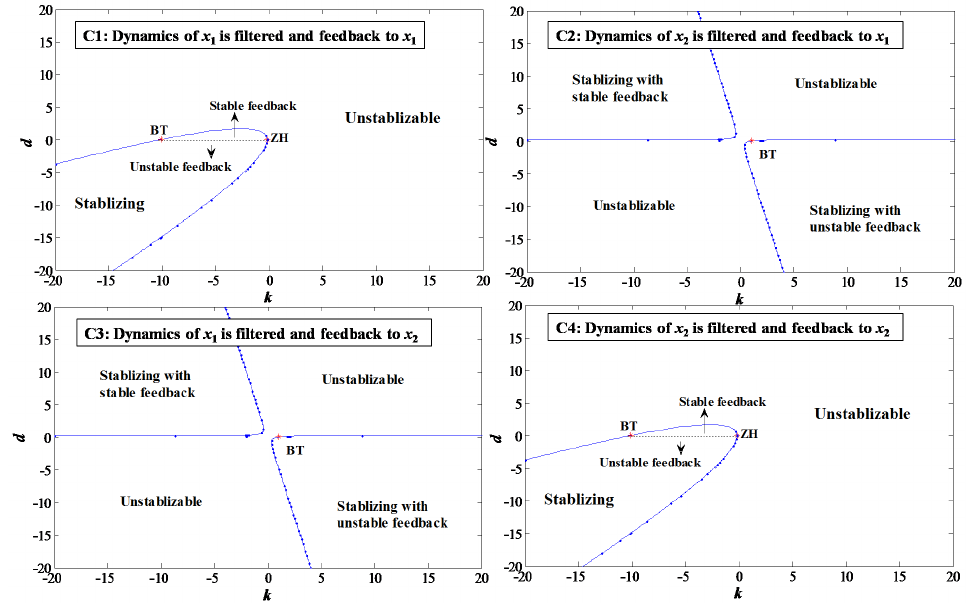
Figure 3. Analysis on the closed system of normal form Andronov − Hopf